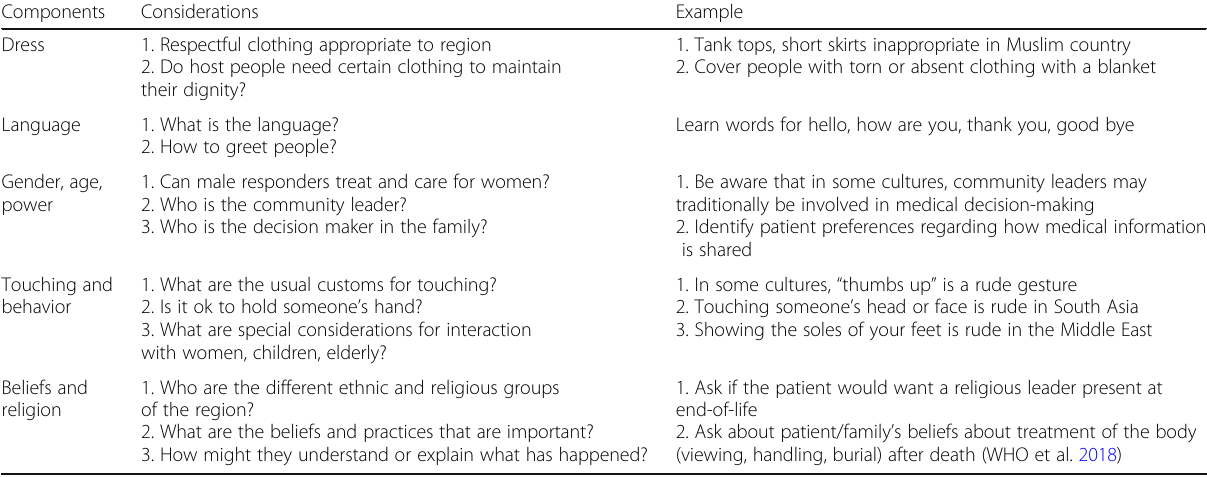
Table 3 Components of cultural